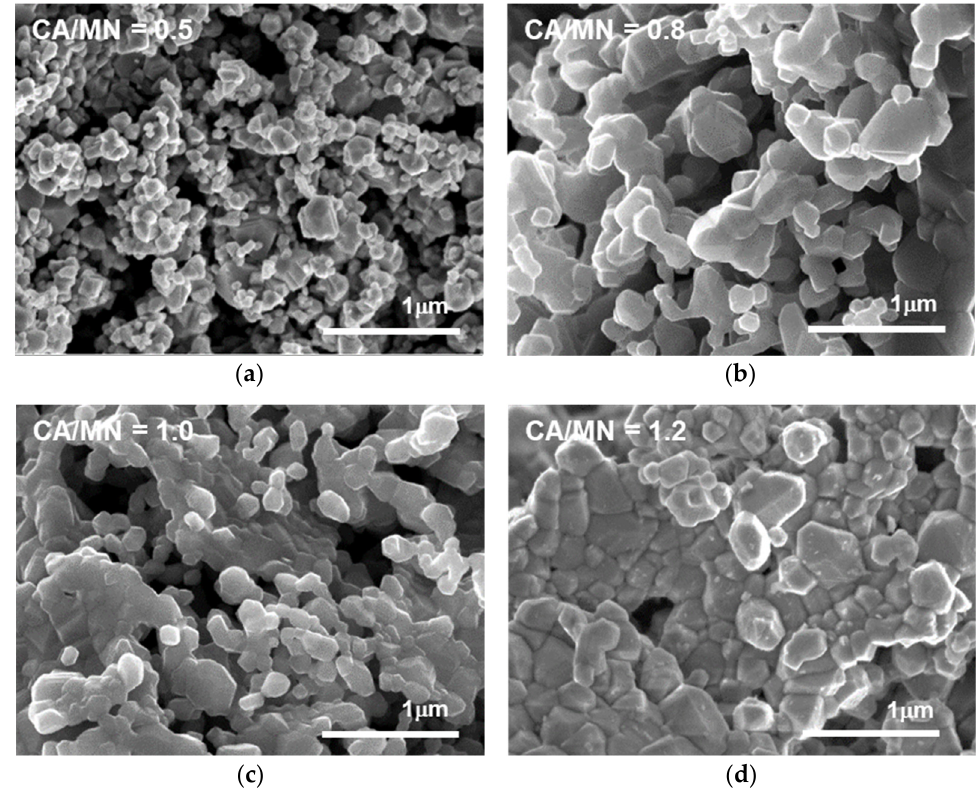
Figure 4. Morphologies of spinel powders synthesized at CA/MN ratios of ( a ) 0.5, ( b ) 0.8, ( c ) 1.0, and ( d ) 1.2.